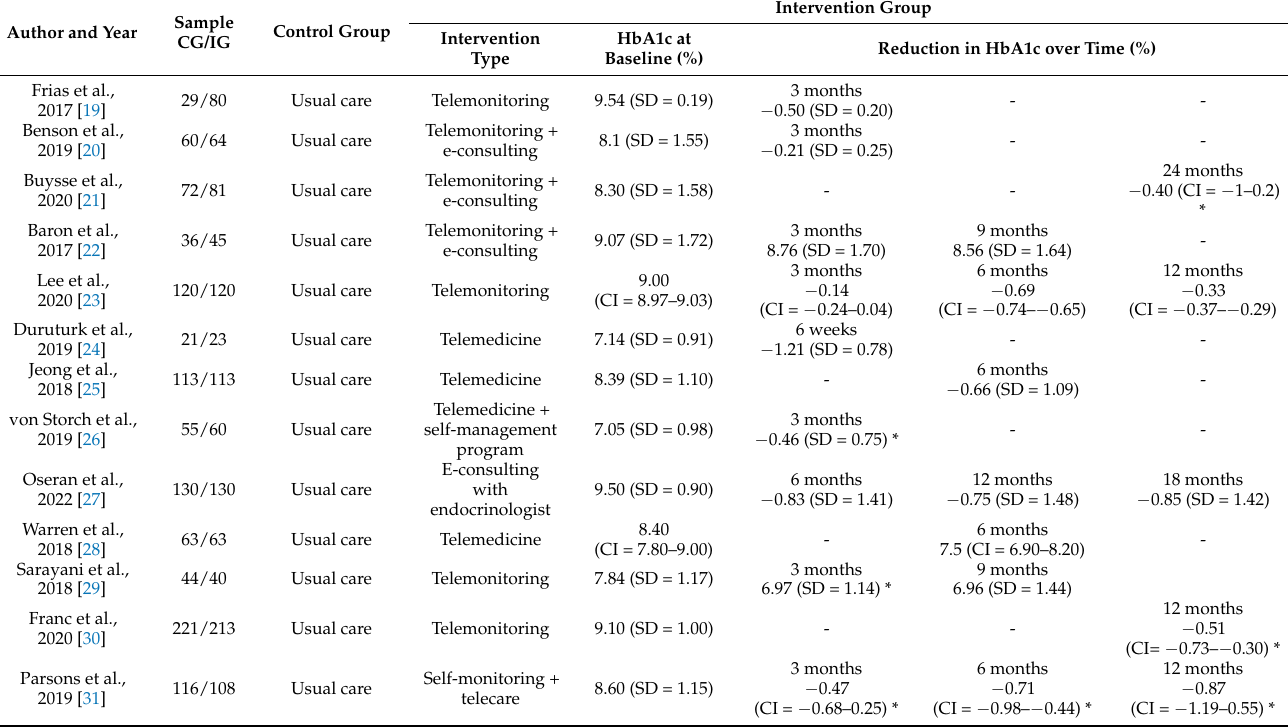
Table 2. Effects of telemedicine-based interventions in persons with diabetes.